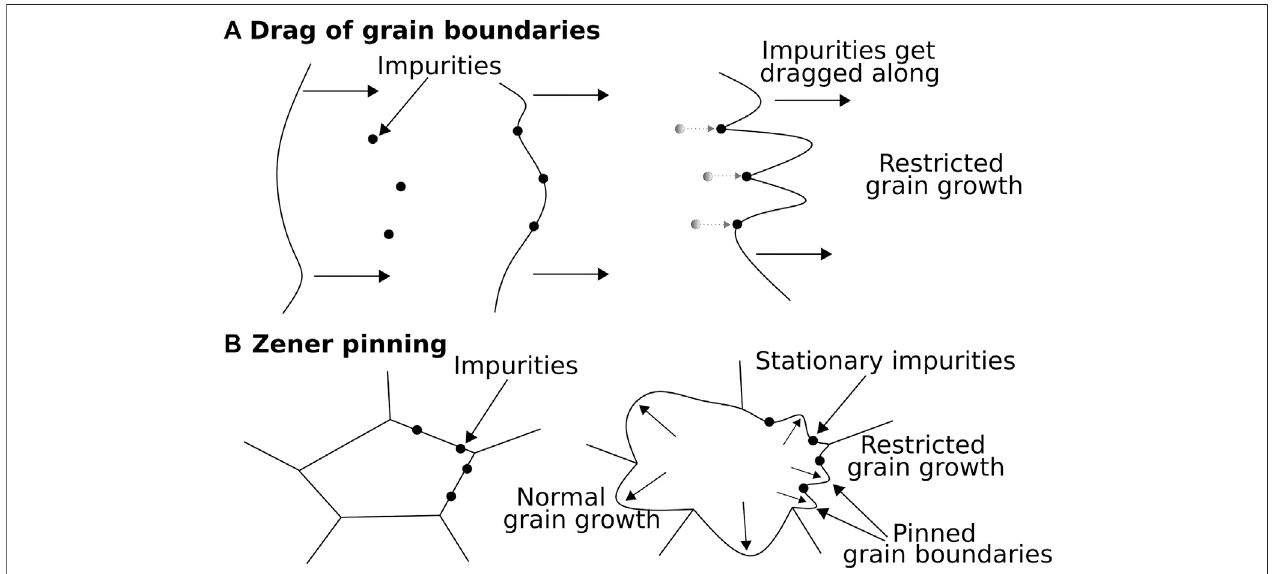
FIGURE 2| Drag of grain boundaries by impurities and Zener pinning. (A) Grain boundaries migrate towards impurities and drag them along. The drag force of the impurities slows down grain growth. (B) A grain expands as the grain boundaries migrate and impurities at grain boundaries stay fi xed in place, limiting grain growth of pinned grain boundaries. Simpli fi ed and combined from Figure 3 from Alley et al. (1986a) and Figure 3 from Kelka et al. (2015).